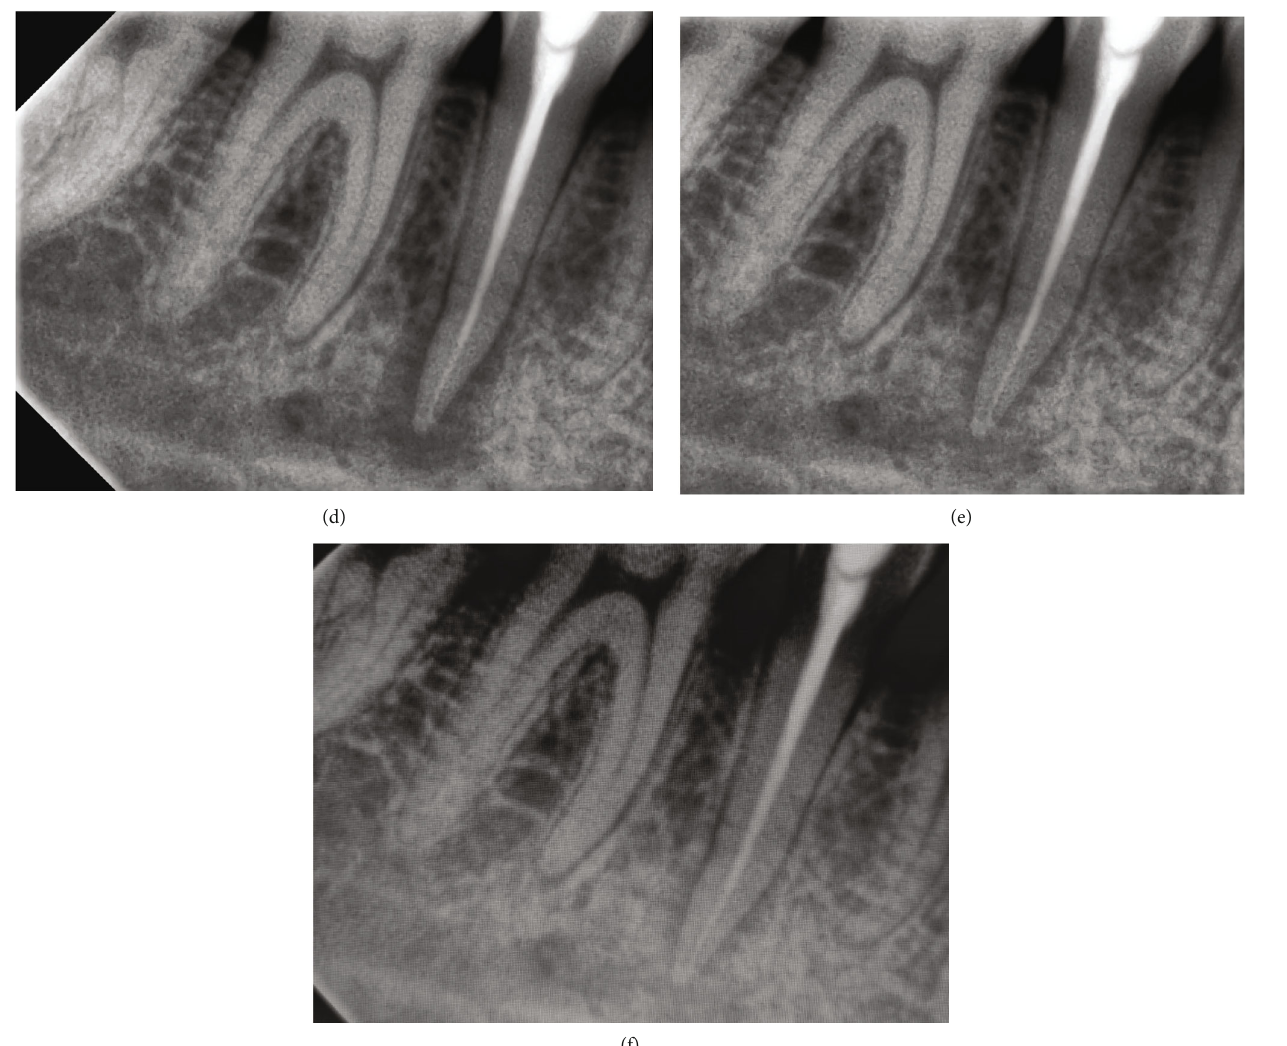
Figure 2: (a) Working length determination, (b) calcium hydroxide placement, (c) master cone selection, (d) obturation, (e) 3-month follow-up, and (f) 6-month